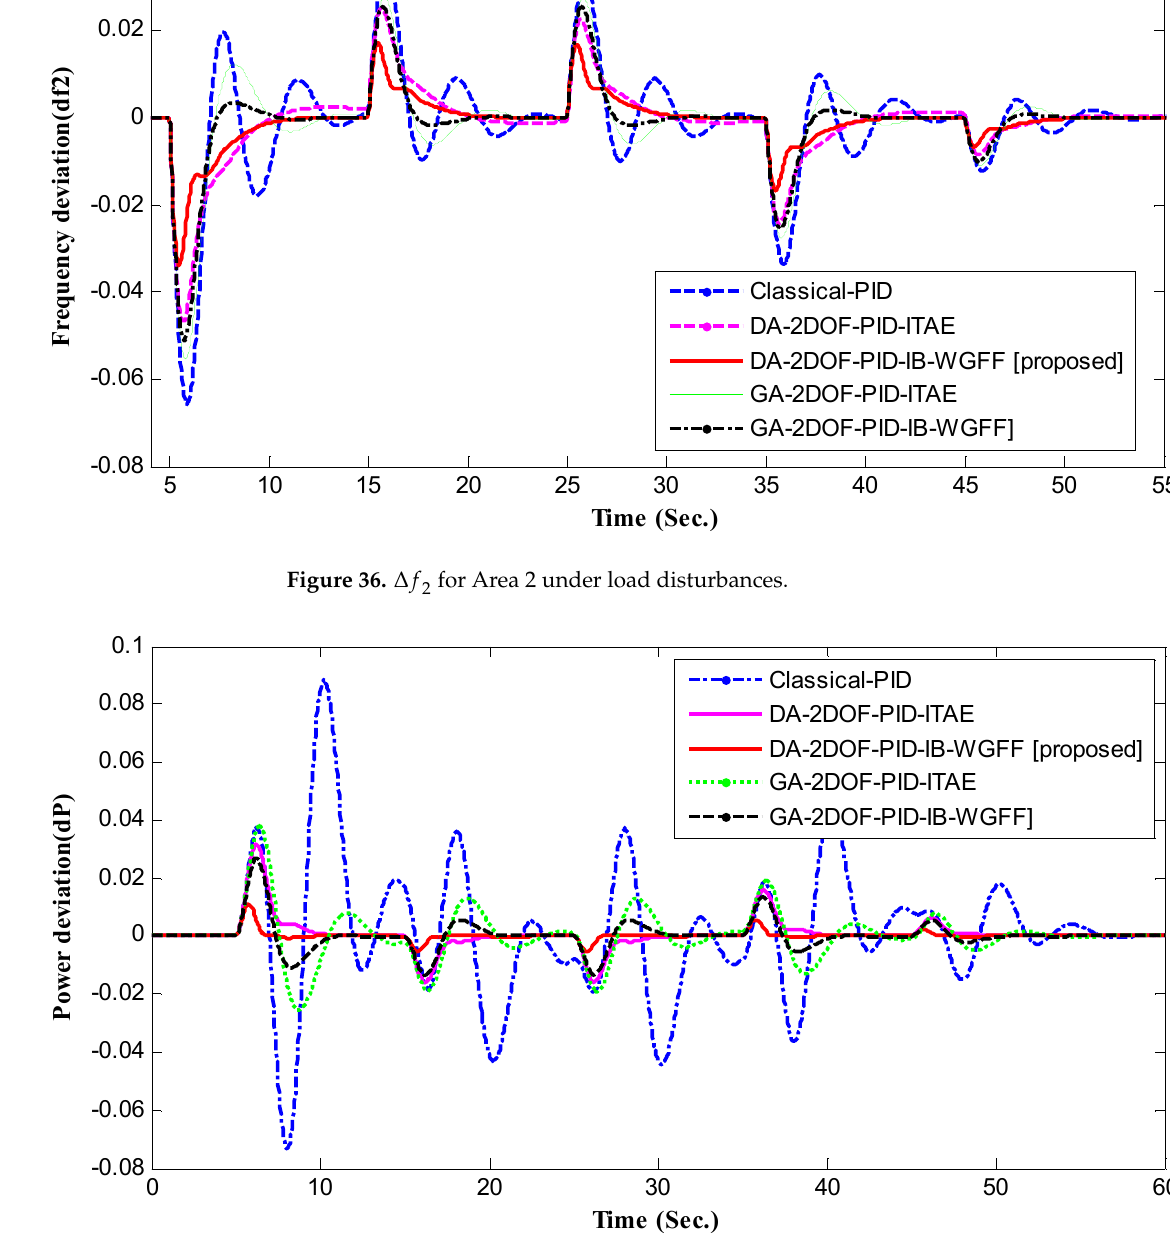
Figure 37. Δ P under load disturbances using different controllers.